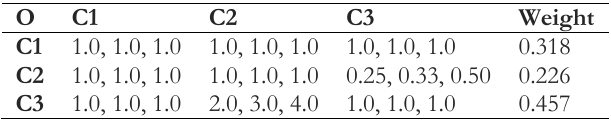
Table 2. The fuzzy comparison matrix of main criteria in regard to the overall